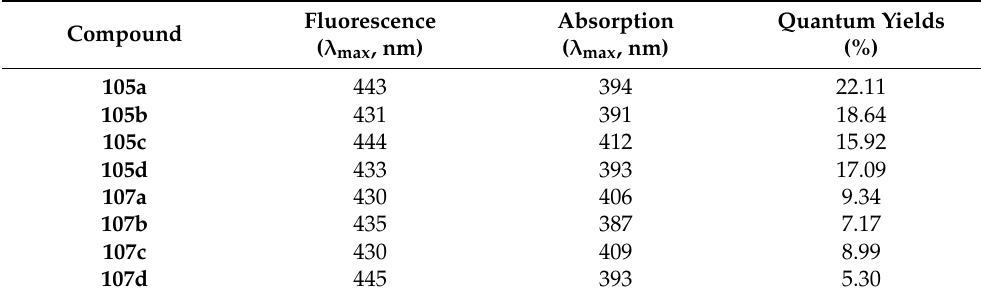
Table 18. λ max (nm) of absorption spectra, λ max (nm) of emission spectra and fluorescence quantum yield (%) of compounds 105a – d and 107a – d . Fluorescence Absorption Quantum Yields Compound ( λ max , nm) ( λ max , nm) (%) 105a 443 394 22.11 105b 431 391 18.64 105c 444 412 15.92 105d 433 393 17.09 107a 430 406 9.34 107b 435 387 7.17 107c 430 409 8.99 107d 445 393